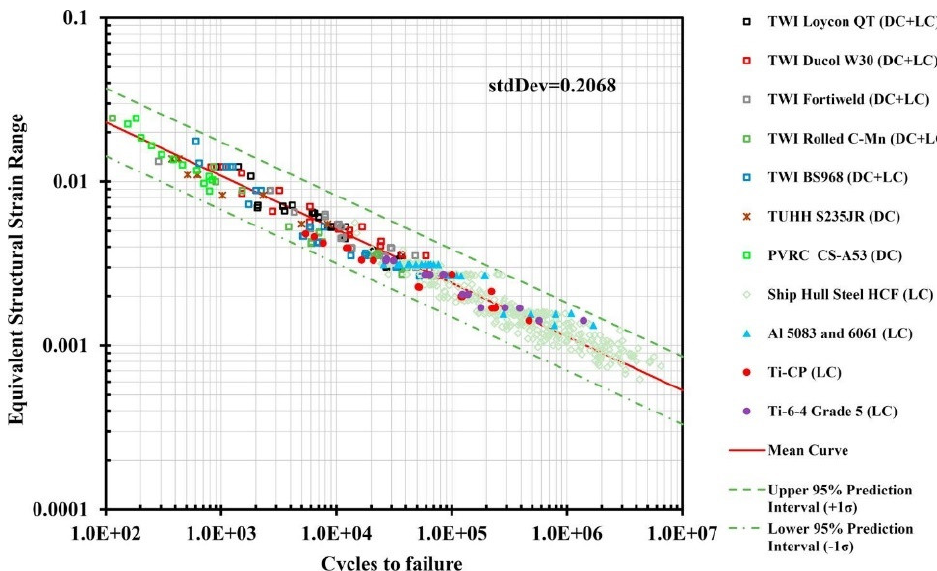
Figure 17. Equivalent structural strain range versus cycle to failure: fatigue test data analyzed in [65]. Reprinted with permission from ref. [65]. Copyright 2019 Elsevier.